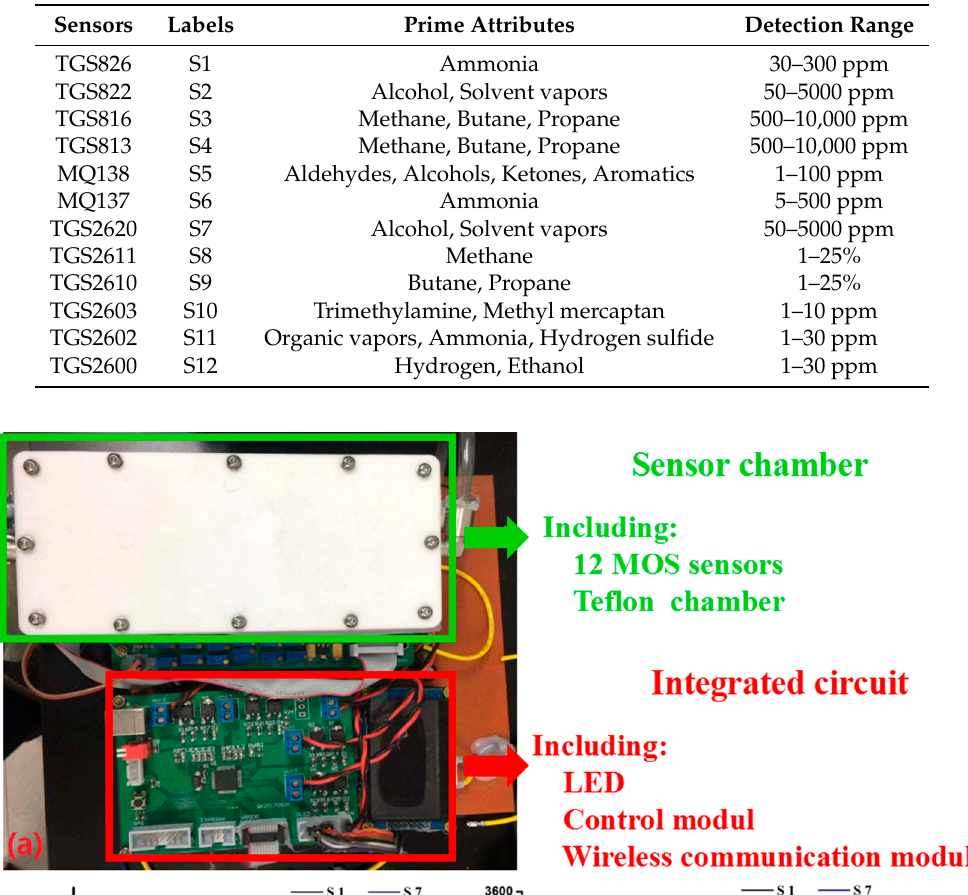
Table 1. The 12 MOS Sensors of e-Nose and Their Performance.